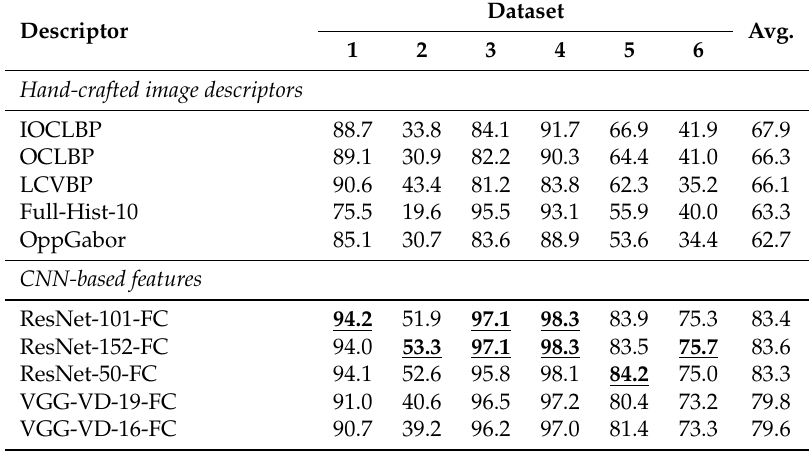
Table 15. Results of Experiment #9: stationary textures with multiple variations. Figures report overall accuracy by dataset. Boldface denotes the highest value; underline signals a statistically-significant difference between the best hand-crafted and the best CNN-based descriptor. Descriptors are listed in ascending order of by-experiment rank (best